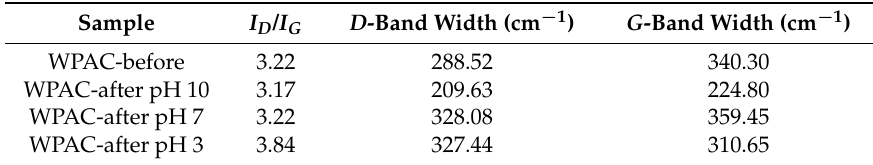
Table 1. G - and D -band widths and I D / I G ratios for WPAC before and after Cr(VI) adsorption at pH 3, 7, and